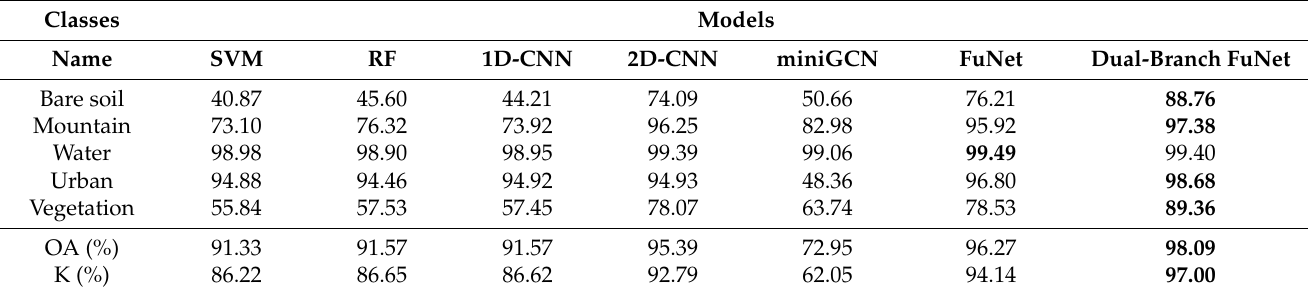
Table 5. Detailed classification OAs and K of different algorithms compared to the proposed method on AIRSAR San Francisco. Bold numbers indicate the highest accuracy in each